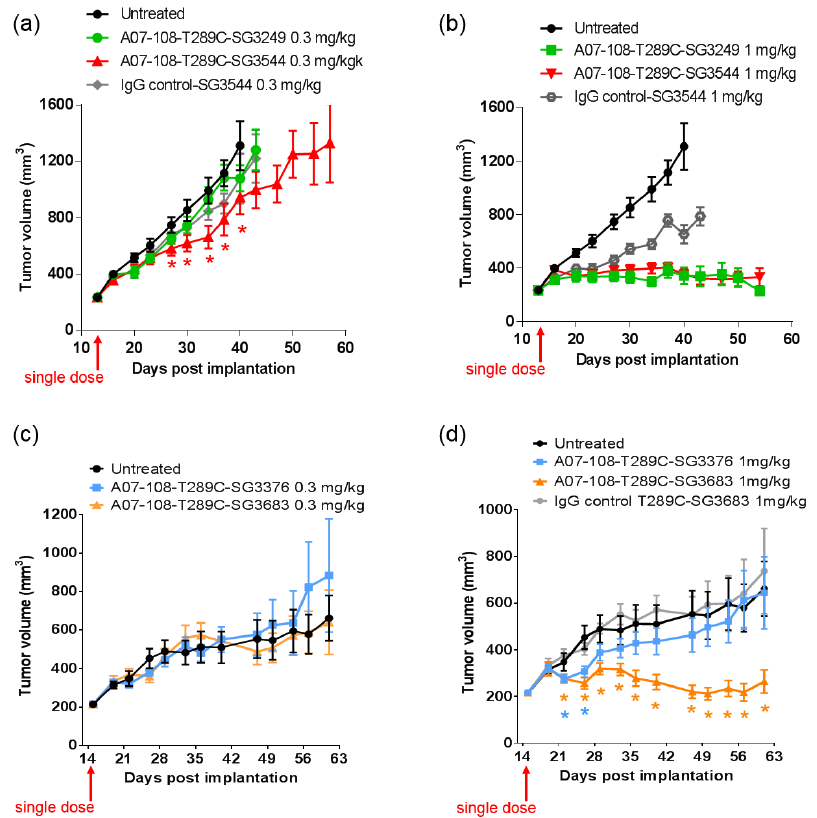
Figure 7. Tumor growth inhibition of MDA-MB-361 tumor models in mice following treatment with A07-108 antibody-drug conjugates (ADCs). ADCs were administered by a single dose I.V. as indicated. ( a ) Cleavable ADCs dosed at 0.3 mg/kg; ( b ) cleavable ADCs dosed at 1 mg/kg; ( c ) Non-cleavable ADCs dosed at 0.3 mg/kg; ( d ) Non-cleavable ADCs dosed at 1 mg/kg. Data represents the average tumor volume ± standard deviation, n = 10. Statistical difference ( p < 0.05) between ADC-treated groups and non-treated controls are indicated with * symbols in ( a , d ) where * symbols are colored to match the corresponding curve color.